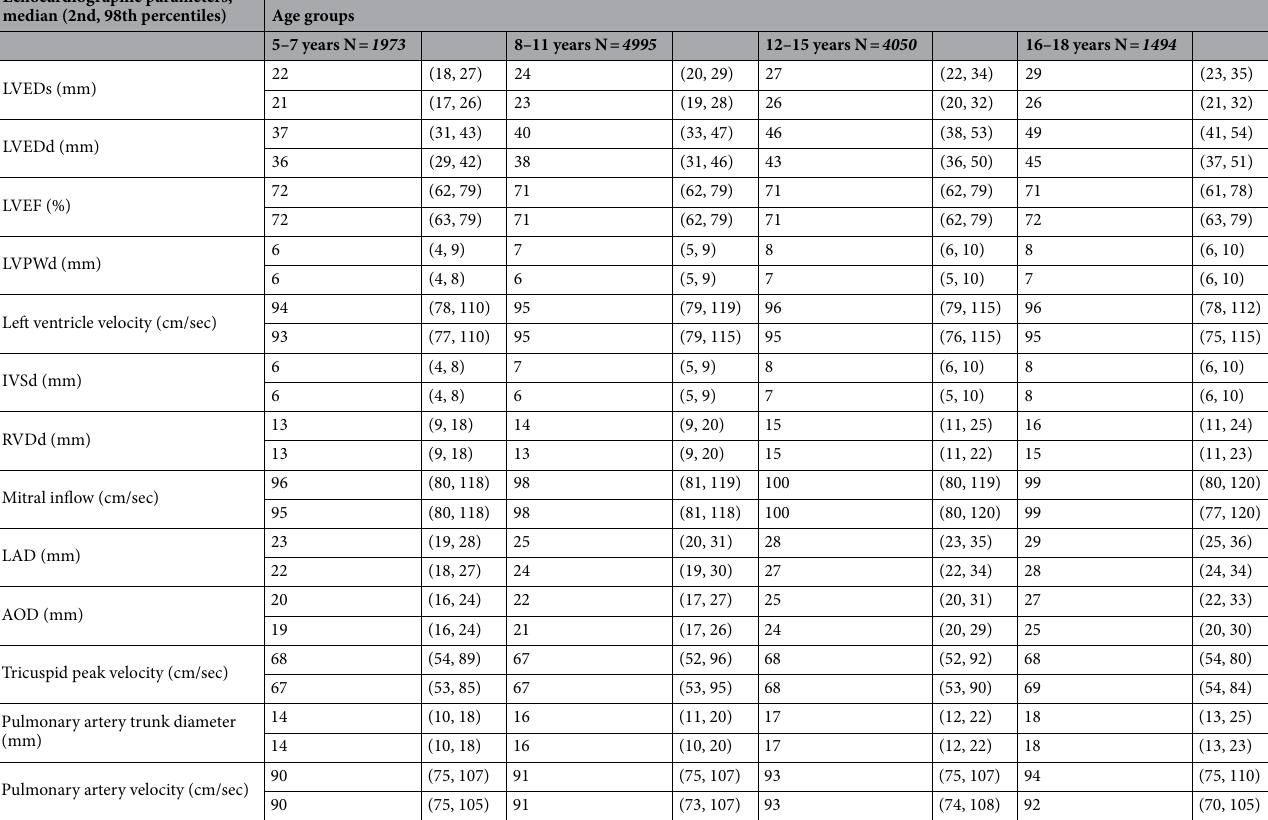
Table 4. Echocardiographic parameters according to age and gender (males, upper row and females, lower row). LVEDs, left ventricular diameter at end-systole; LVEDd, left ventricular diameter at end-diastole; LVEF, left ventricle ejection fraction; LVPWd, left ventricular posterior wall thickness at end-diastole; IVSd, interventricular septum thickness at end-diastole; RVDd, right ventricular diameter at end-diastole; LAD, left atrial diameter; AOD, aortic